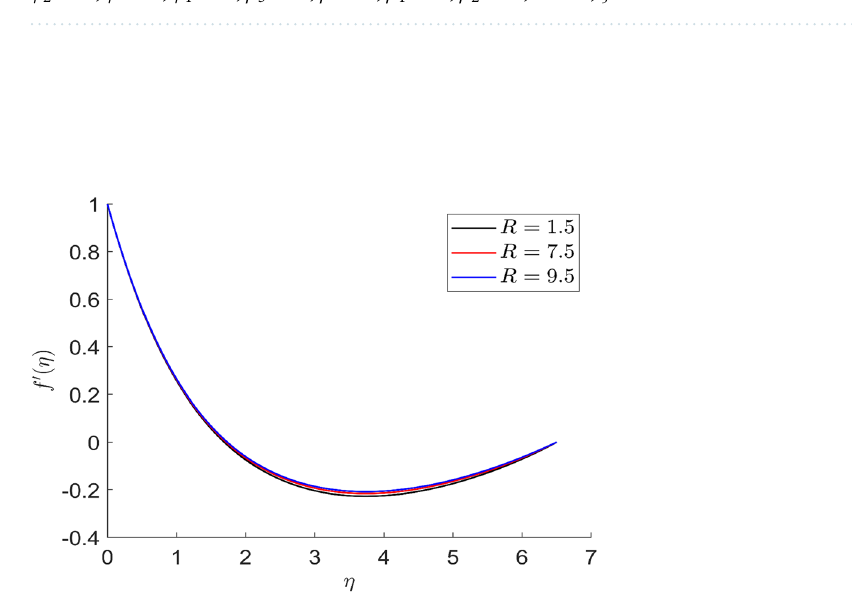
Figure 21. Representation of axial velocity f (η) for the different values of R with R = 3, n = 3, v = 0.7, m = 1.5, φ 2 = 0.8, φ = 0.3, φ 1 = 0.1, β 3 = 0.5, β = 0.4, β 1 = 0.5, β 2 = 0.9, u = 0.2, ξ = 0.2.